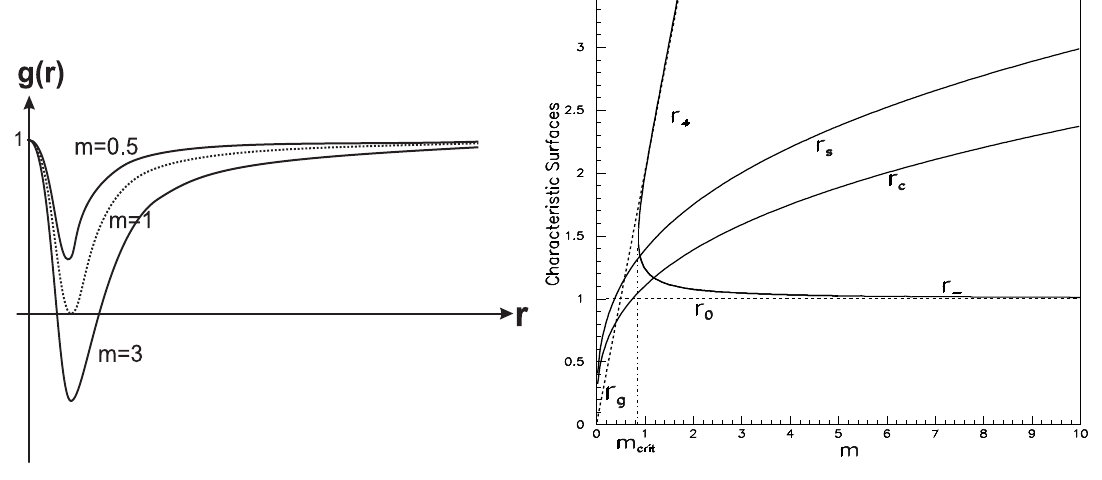
Figure 1. Typical behavior of the metric function g ( r ) for the asymptotically flat case ( left ); horizons r + , r − and surfaces r s upper, r = r c lower ( right ).